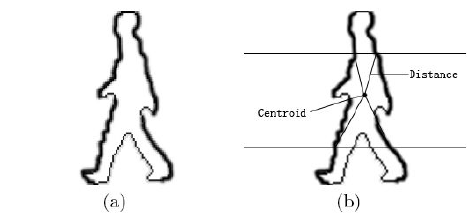
Fig. 3. (a) the schematic of outermost contour , (b) illustra- tion of distance signal